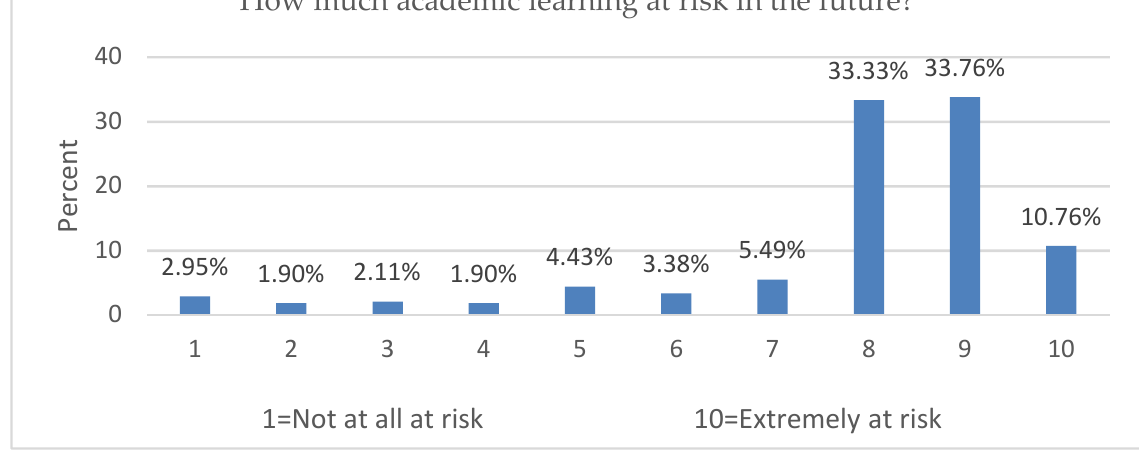
Figure 6. Evaluation of the impact of COVID-19 on academics in the future. Table 4 compares the means of demographic variables and perceived stress scores. In perceived stress, financial and behaviour stress, females show a significantly greater number of 3.92, 3.67, and 3.57, respectively; except in the academic stress, the males show a significantly greater number of 3.51. Table 4. Perceived stress and stressors score by